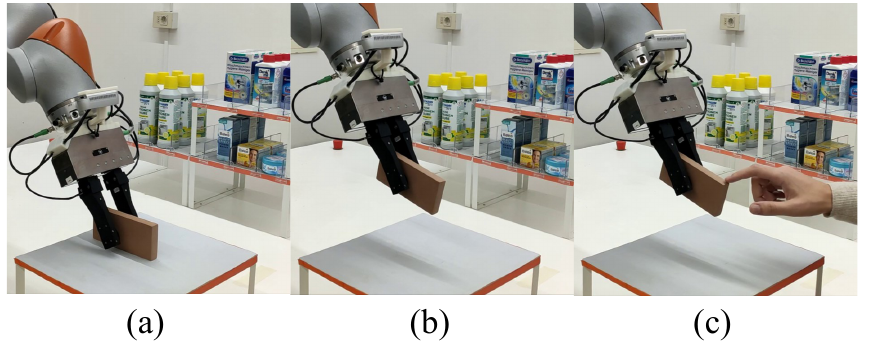
Figure 12. Snapshots of the second experiment: ( a ) grasp configuration; ( b ) after lifting; ( c ) distur- bance applied by a human